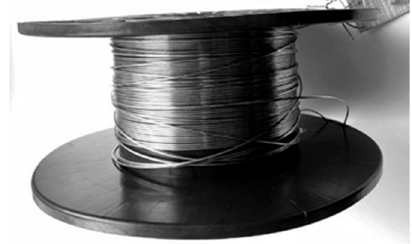
Figure 4. The resulting wire.